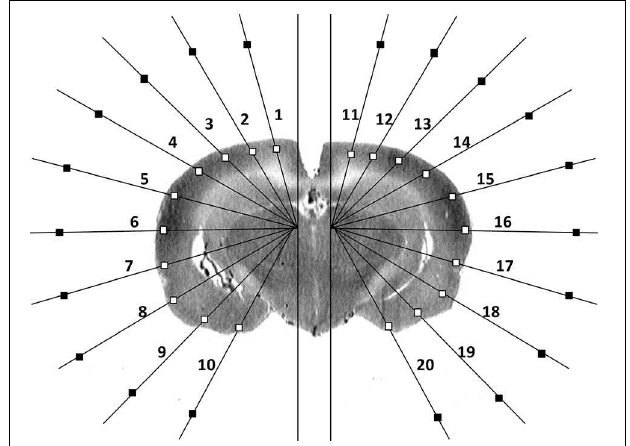
FIGURE 1 | Schematic of region-of-interest and background selections in a single coronal brain autoradiographic slice as reported previously